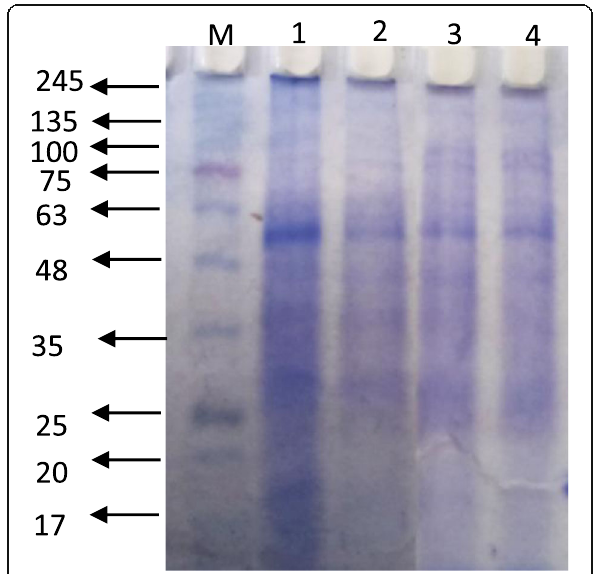
Fig. 3 SDS-PAGE of protein extracted for G3 cultivar under control and treatment with different EMS doses. M marker, lane 1 = G3 (control), lane 2 = G3 (0.1 EMS), lane 3 = G3 (0.2 EMS), lane 4 = G3 (0.3 EMS)